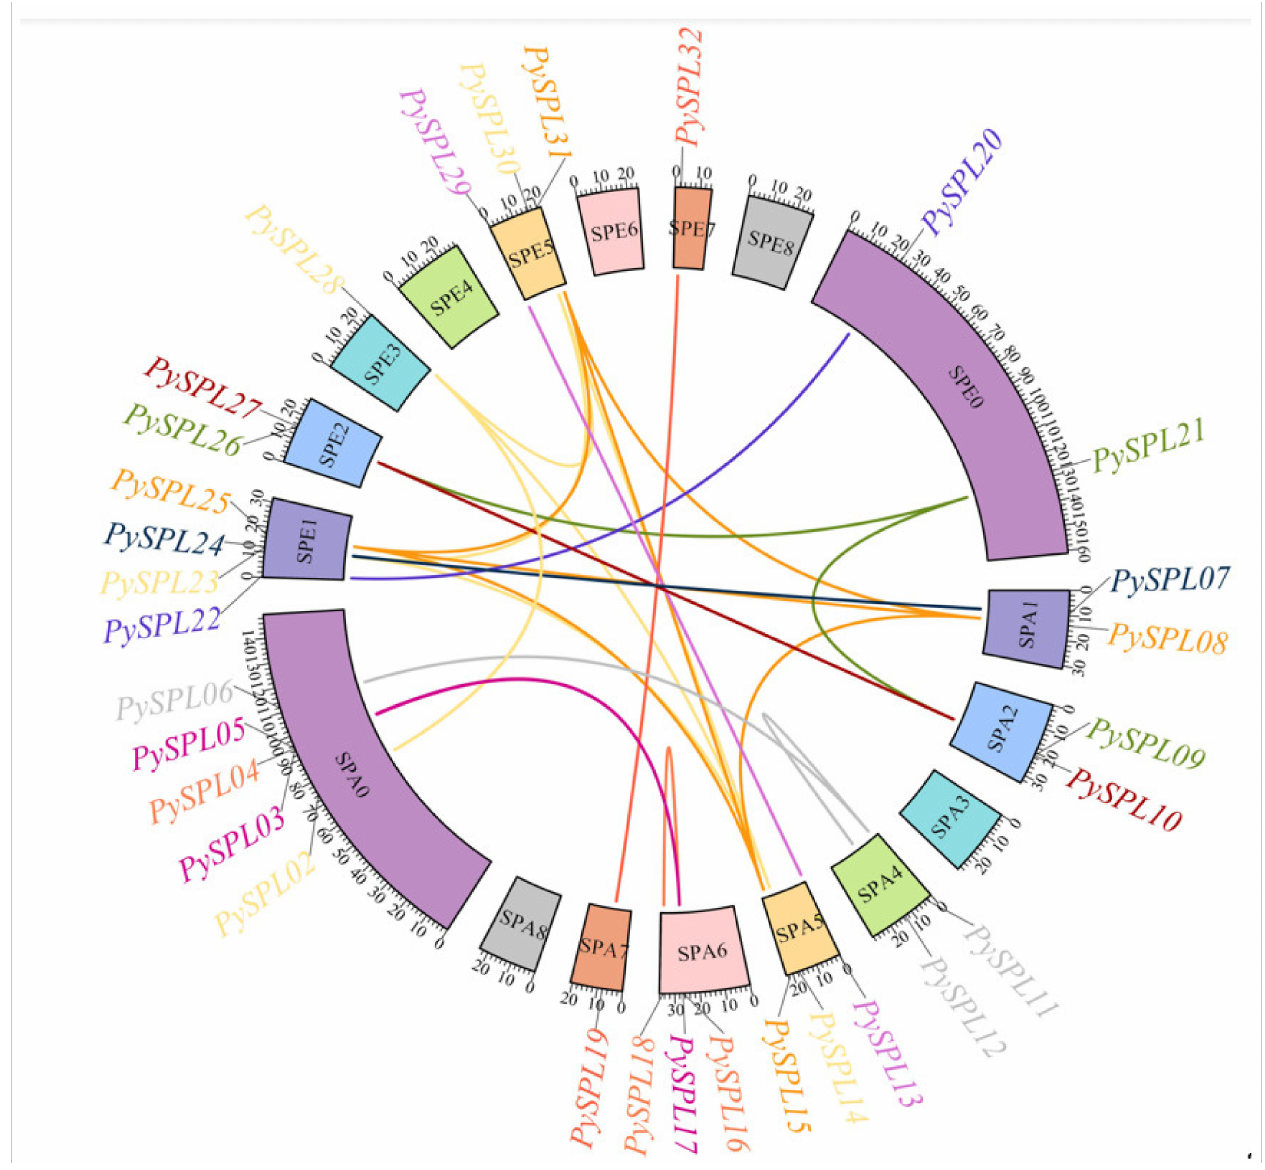
Figure 6. Collinearity analysis of PySPLs in Prunus × yedoensis ’Somei-yoshino’. The chromosome number is marked in the middle of each chromosome. The scale bar of chromosome length is Mb, genes with segmental duplication relationships has the same color